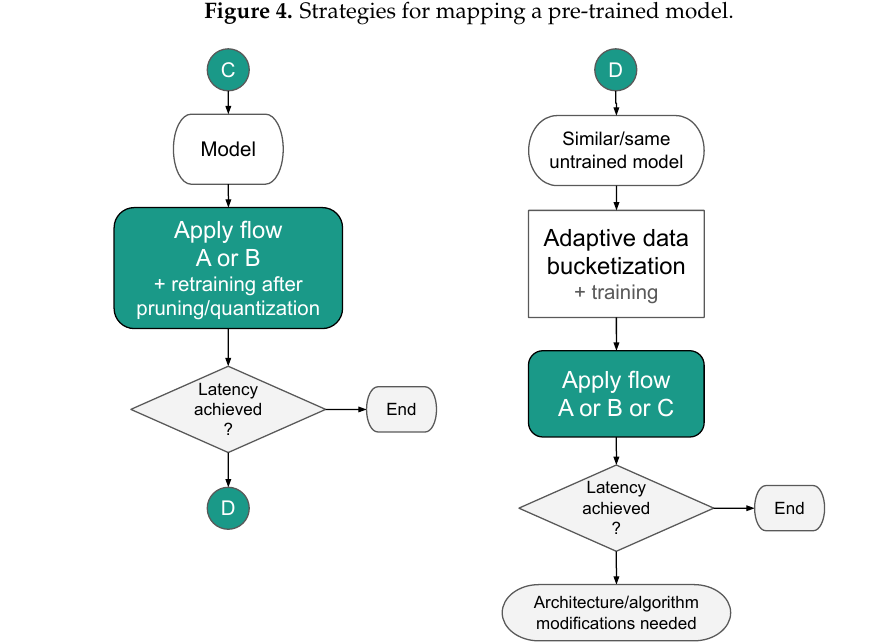
Figure 4. Strategies for mapping a pre-trained model.